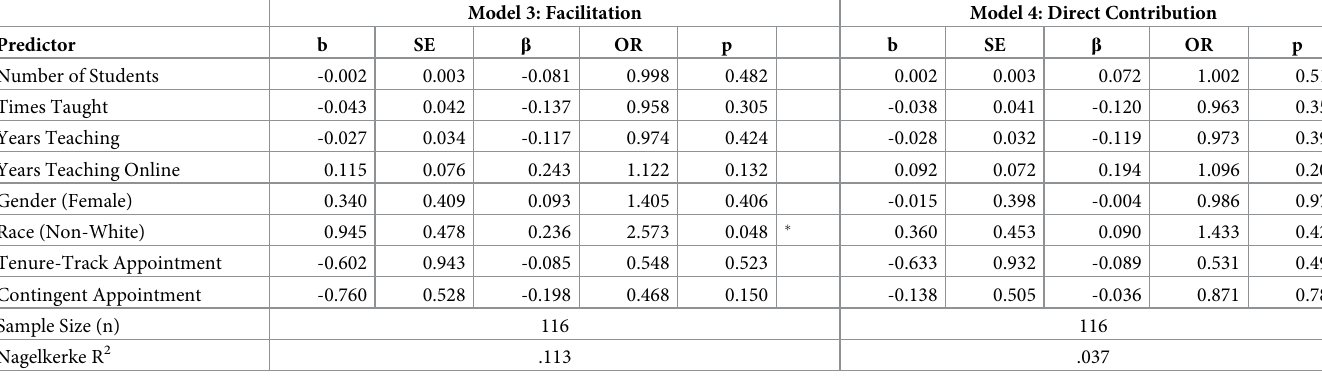
Table 6. Logistic regression predicting discussion contribution